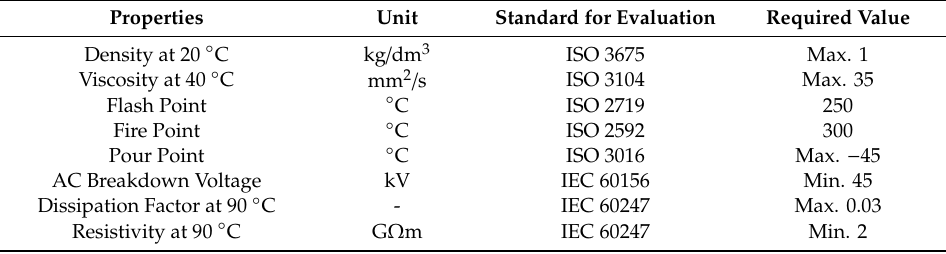
Table 1. Requirements for fresh synthetic ester for electrical purposes as per IEC 61099.